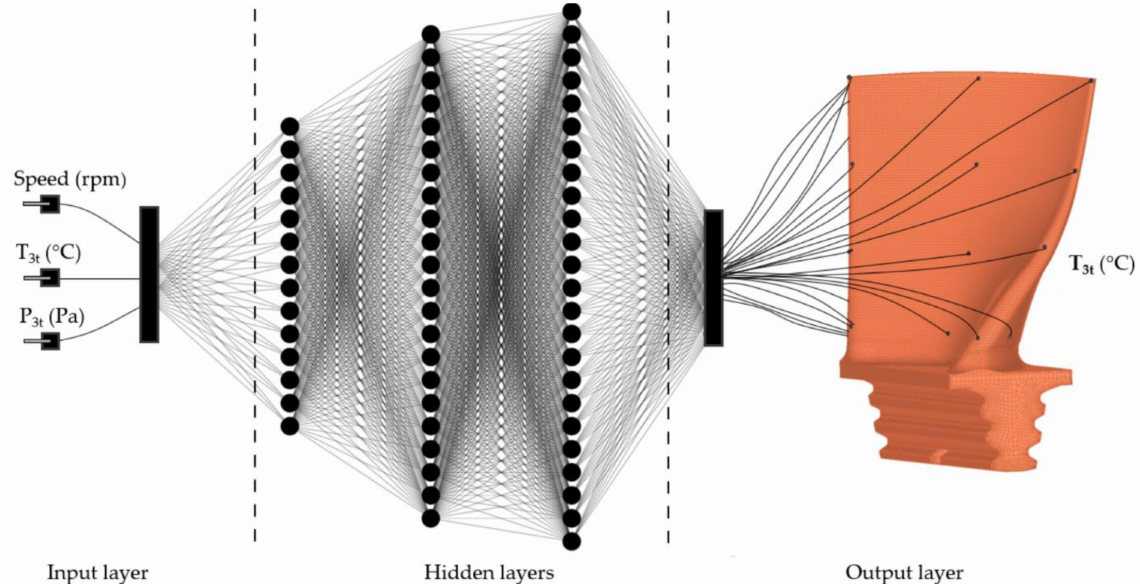
Figure 5. Architecture of the proposed artificial neural networks (ANN) for the temperature field prediction of the turbine